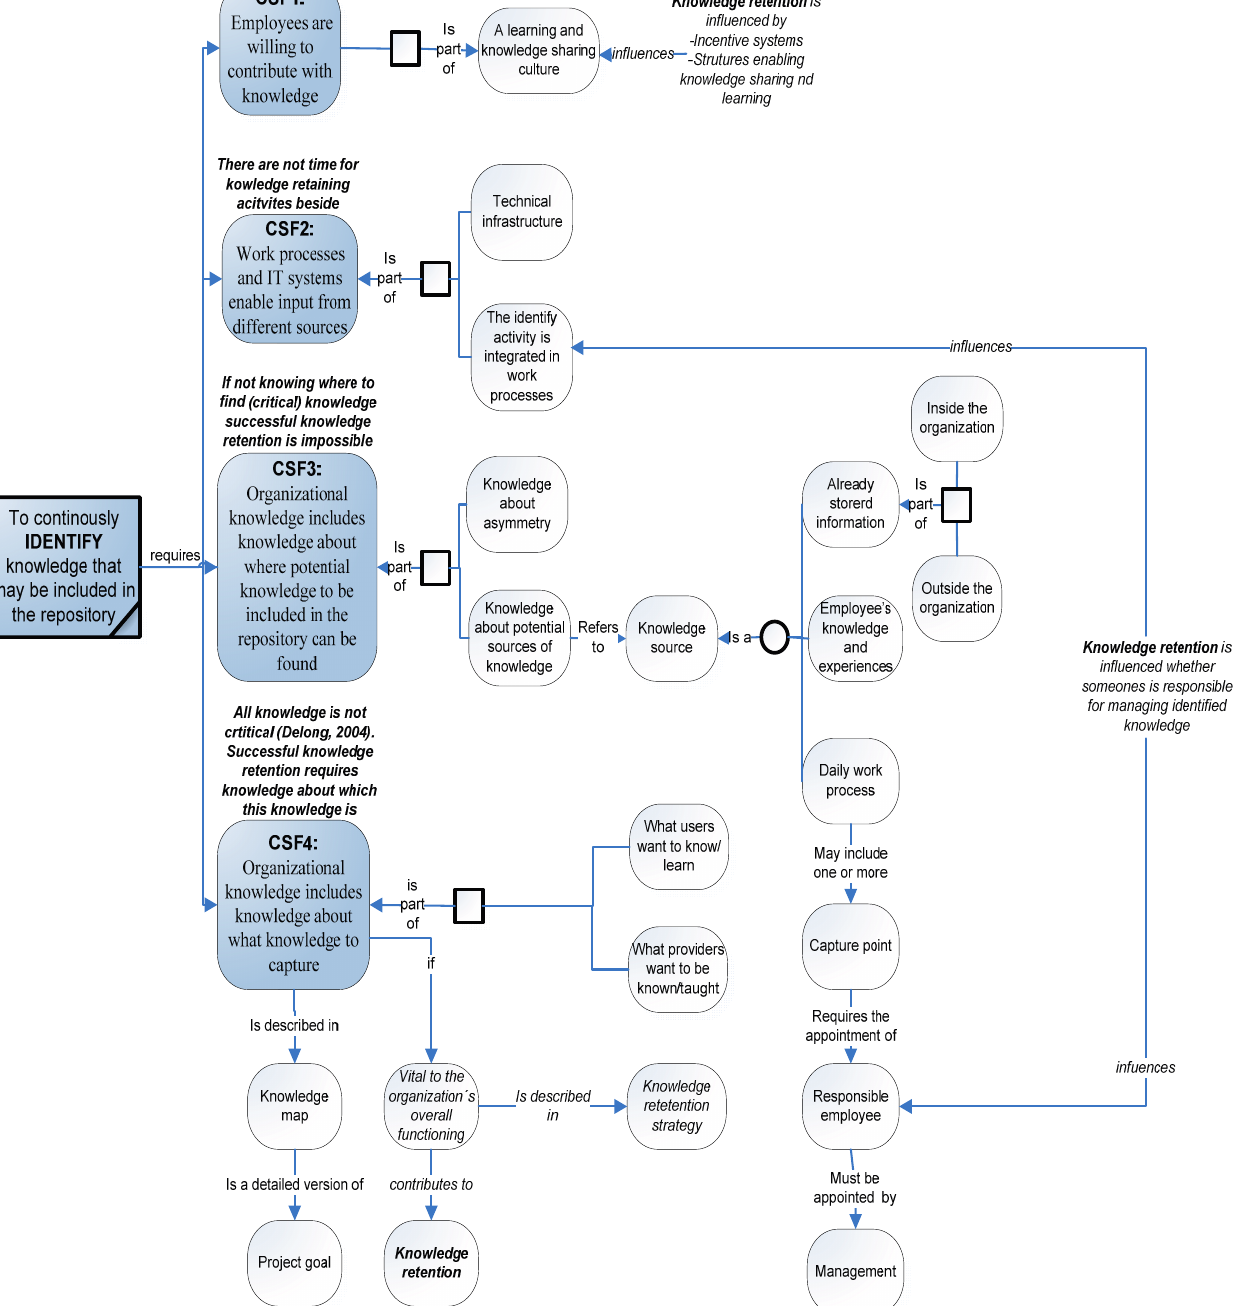
Figure 1. CSF for the identification activity and their influencing factors associated with knowledge